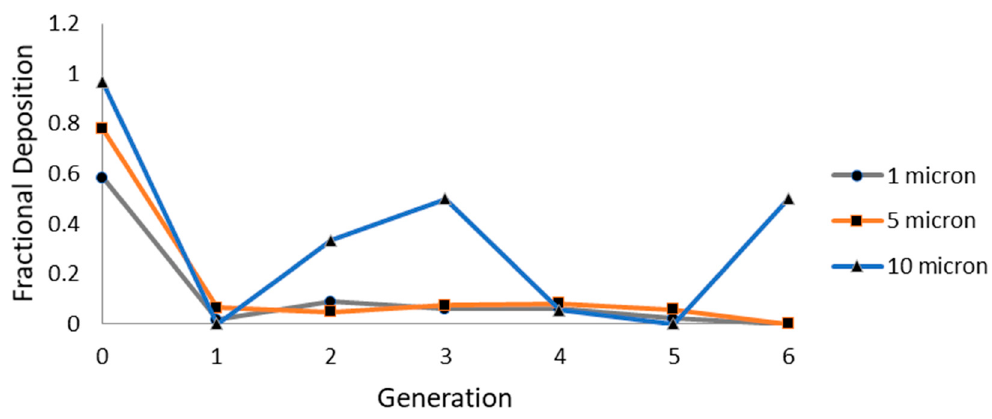
Figure 9. Generation wise deposition fraction of CSP.